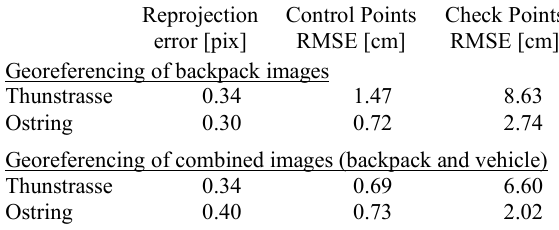
Table 2. Georeferencing: Reprojection error and RMSE in X,Y,Z for control and check